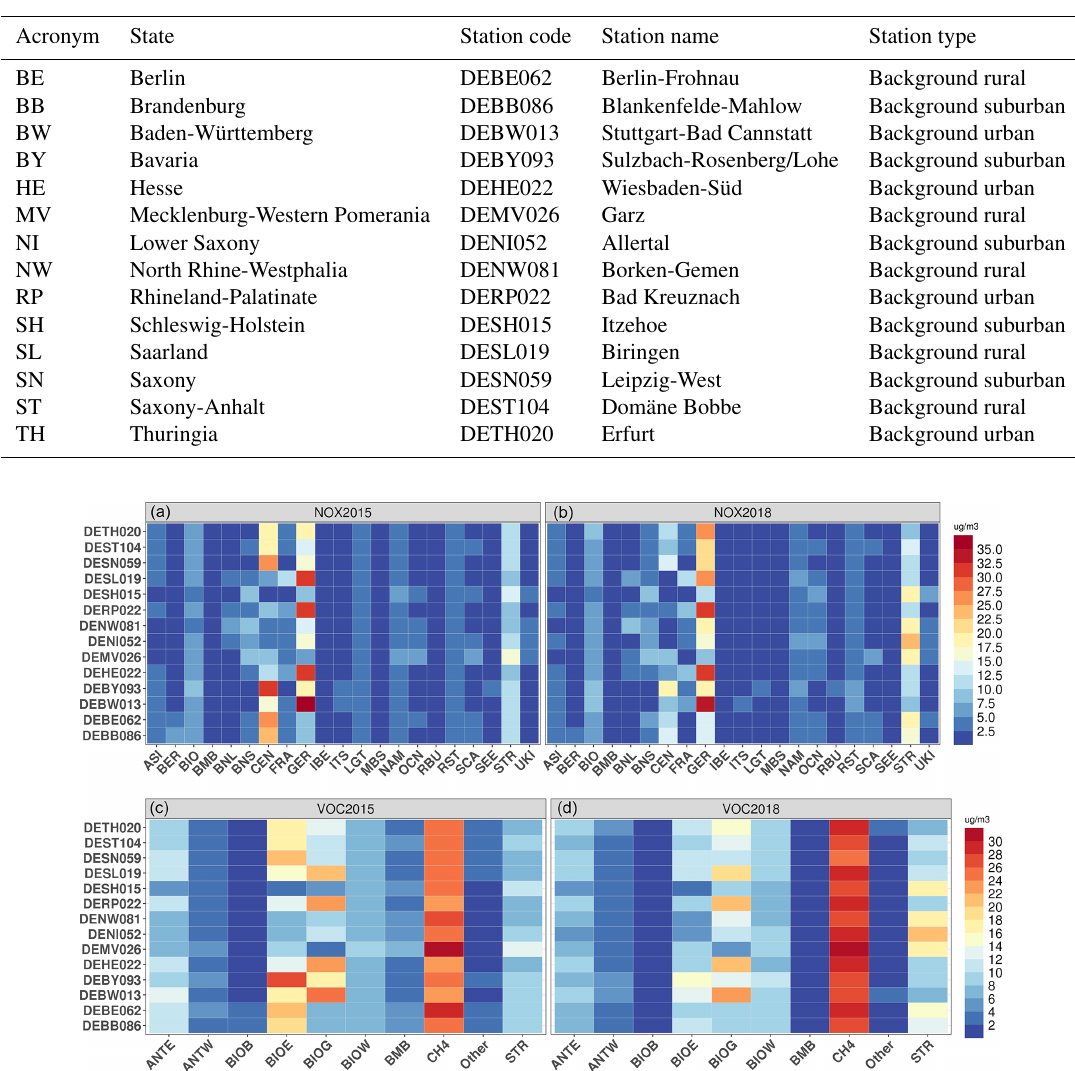
Figure 5. Contribution to mean surface O 3 at 14 receptor stations from local and other European sources, HTAP2 sources, and other global sources. The upper panels denote the mean contribution of NO x precursor to total O 3 during 6–13 August 2015 (a) and 1–8 August 2018 (b) . The bottom panels denote the mean contribution of VOC precursors to total O 3 during 6–13 August 2015 (c) and 1–8 August 2018 (d)